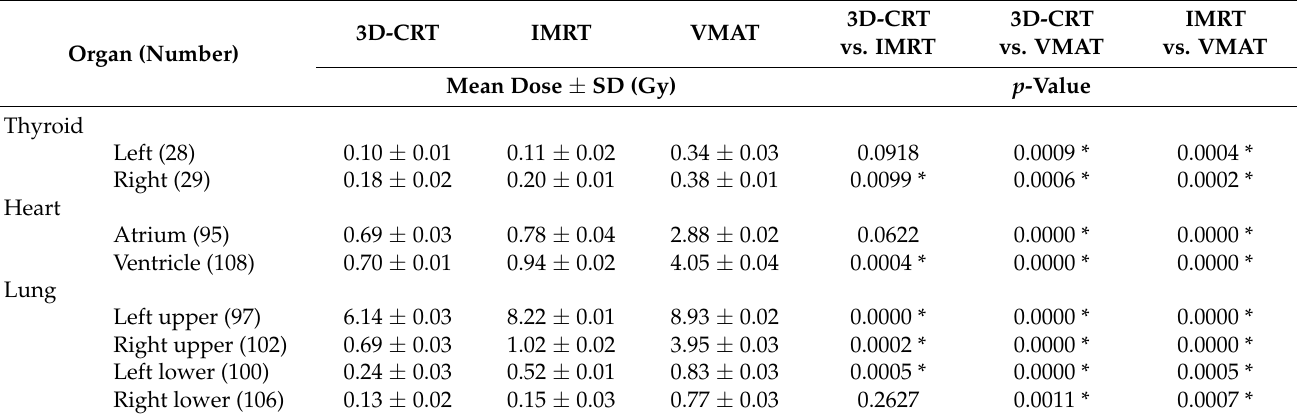
Table 2. Comparison of the average OAR doses of the three